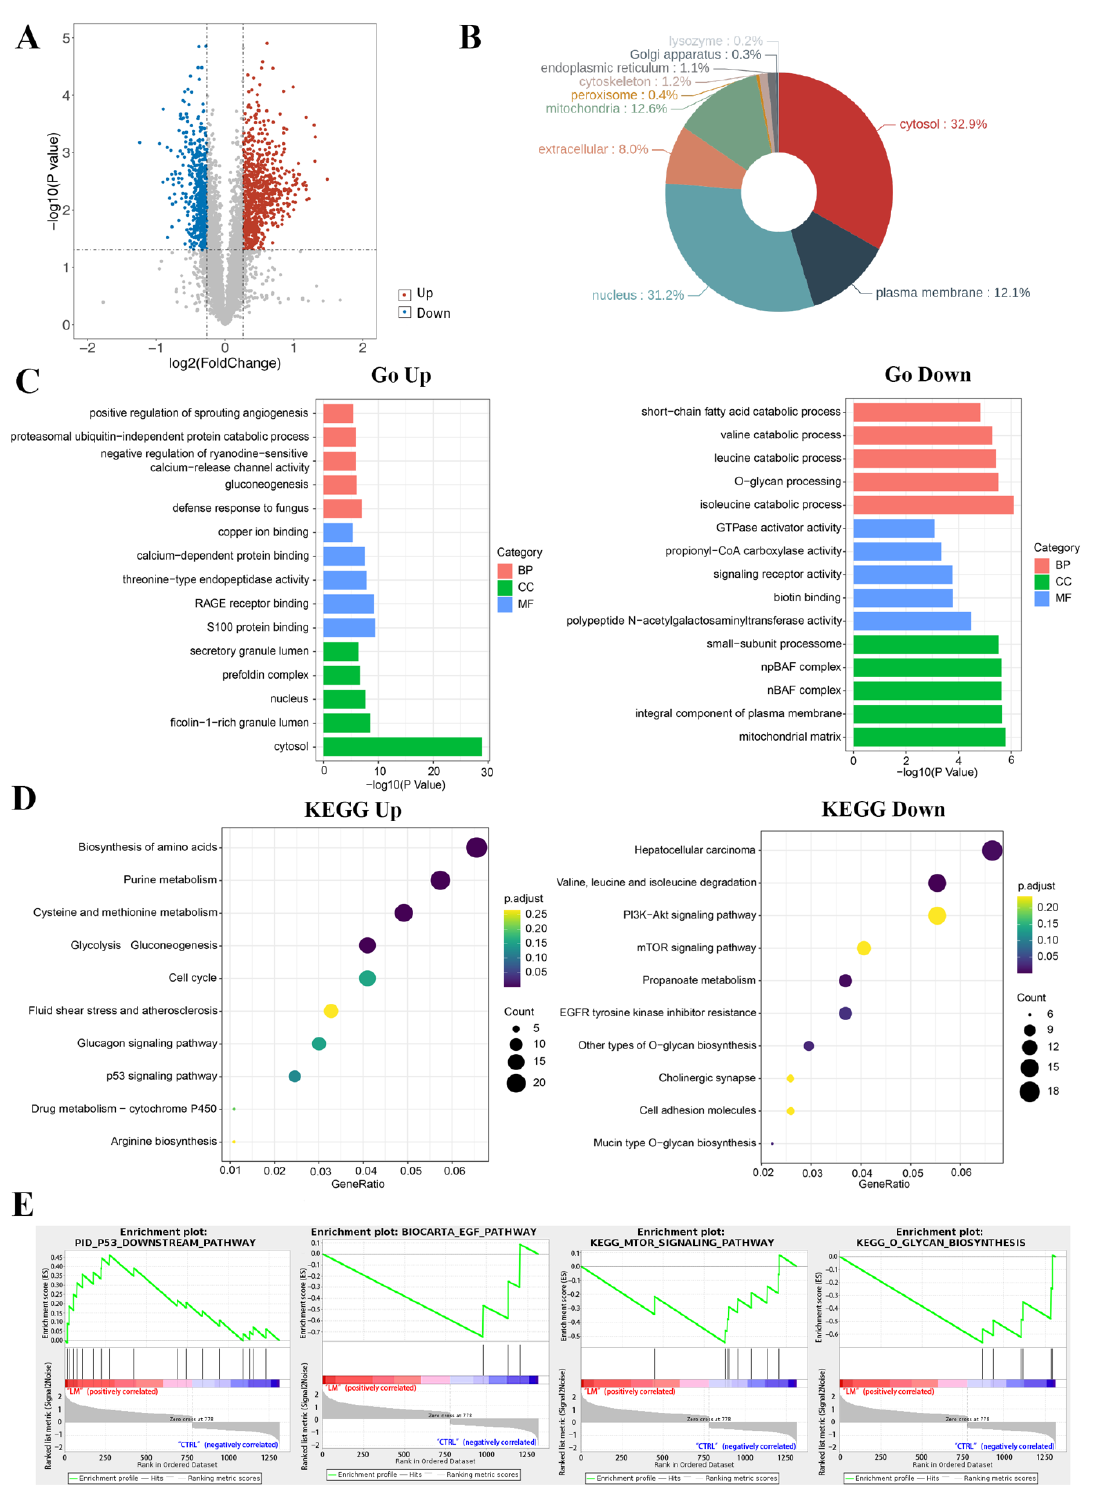
Figure 3. Functional analysis of differential proteins. ( A ) Scatter plots of differentially expressed proteins. There were 778 up-regulated proteins and 536 down-regulated proteins in the LM group. Abscissa is the difference multiple (logarithmic transformation based on 2); ( B ) localization analysis of differentially expressed proteins; ( C ) the gene ontology annotation analysis between DAPs and classification of BP, MF, and CC; ( D ) the KEGG pathway analysis of related DAPs; ( E ) the GSEA results of differentially abundant proteins.